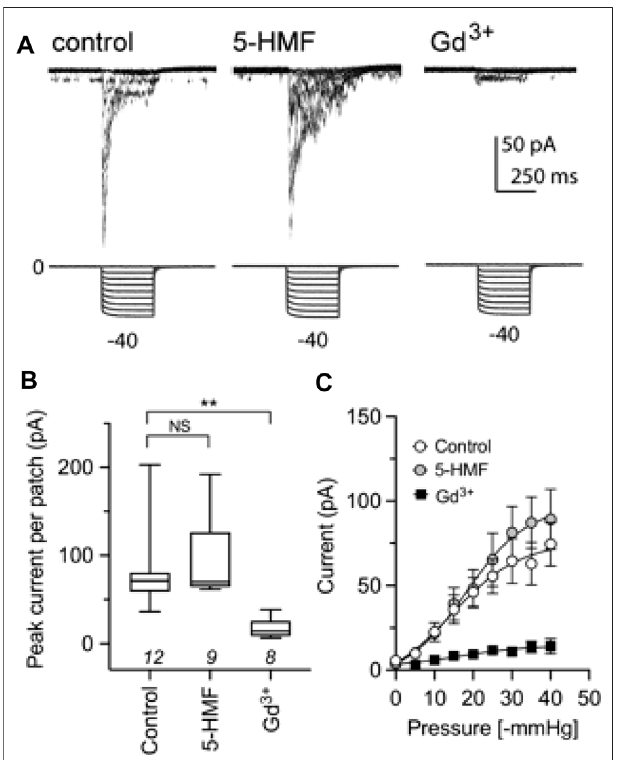
FIGURE 6 | The Piezo1 ion channel conductance is not sensitive to block by 5-HMF. (A) Representative traces from cell-attached recordings of human Piezo1 currents (upper row) measured in HEK293T cells stably transfected with Piezo1, shown for cells in the control treatment (left), after 2 mM 5-HMF for 60 min ( center), or after 100 µM GdCl 3 applied in the bath for ≥ 5 min before patching (right). Square wave pressure pulses (lower row)wereappliedtothepatchpipetteusingahigh-speedpressureclamp. (B) Amplitudes of peak currents recorded from cell attached patches from HEK293T cells in control, 5-HMF and Gd 3+ treatment groups as speci fi ed in panel A. ** is p < 0.01; NS is not signi fi cant; n values are above the x -axis. (C) Pressure-sensitive activation of Piezo1 currents in control, 5-HMF and Gd 3+ treatment groups. Statistical signi fi cance was assessed by Kruskal-Wallis ANOVA and post hoc Dunn ’ s multiple comparisons tests; ** p < 0.01; NS not signi fi